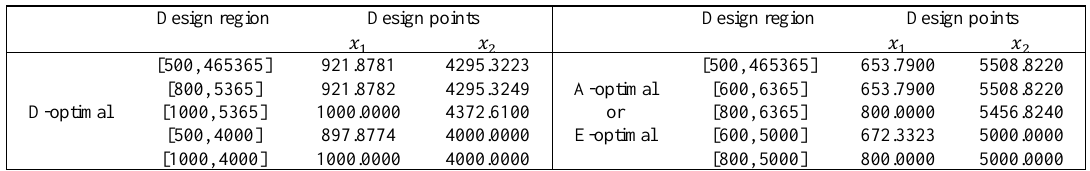
weights 𝑤 = 0.35, 1